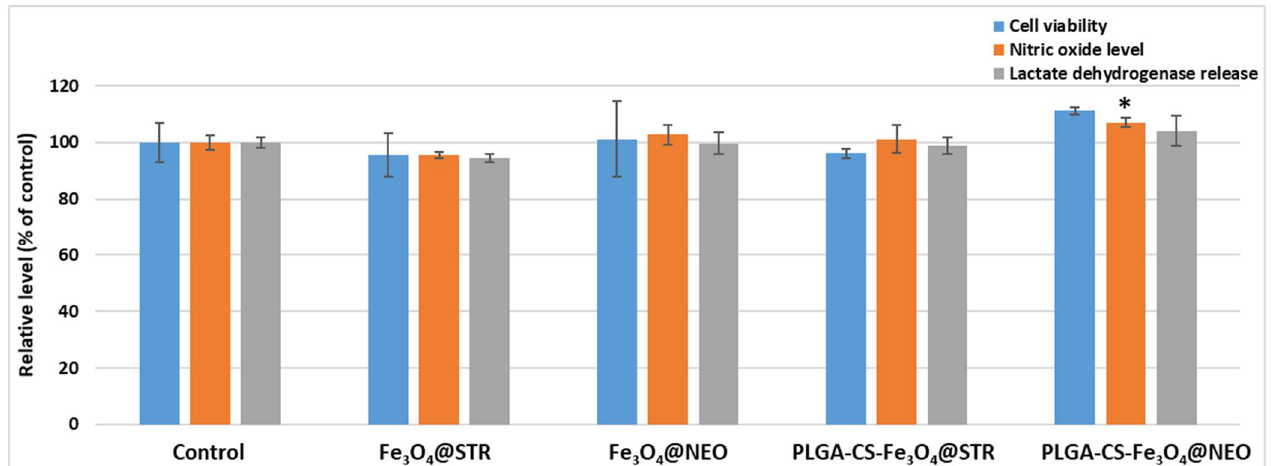
Figure 9. Biological evaluation of Fe 3 O 4 @STR and Fe 3 O 4 @NEO nanoparticles and PLGA-CS- Fe 3 O 4 @STR and PLGA-CS-Fe 3 O 4 @NEO spheres after 24 h of interaction with MRC-5 human cells by